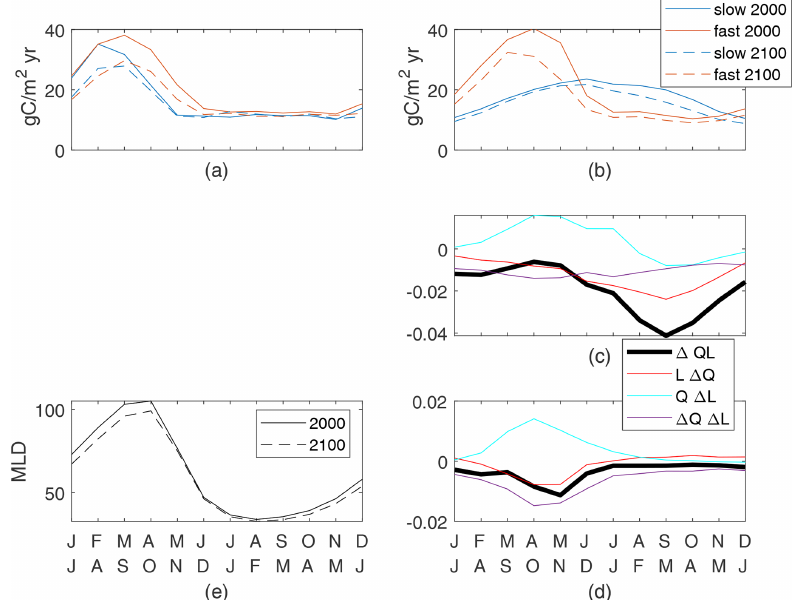
Figure 7. Globally integrated supply of nutrients (a) and production of particulates (b) for the top 100m. Both cases are shown for the 2000s and 2100s; the seasonal cycle is the mean of simulation years 8–10. Production controls (nondimensional) for the slow case (c) normalized by a global maxQL(2000) value of 0.055 and the fast case (d) normalized by a global maxQL(2000) value of 0.14. (e) Mean mixed-layer